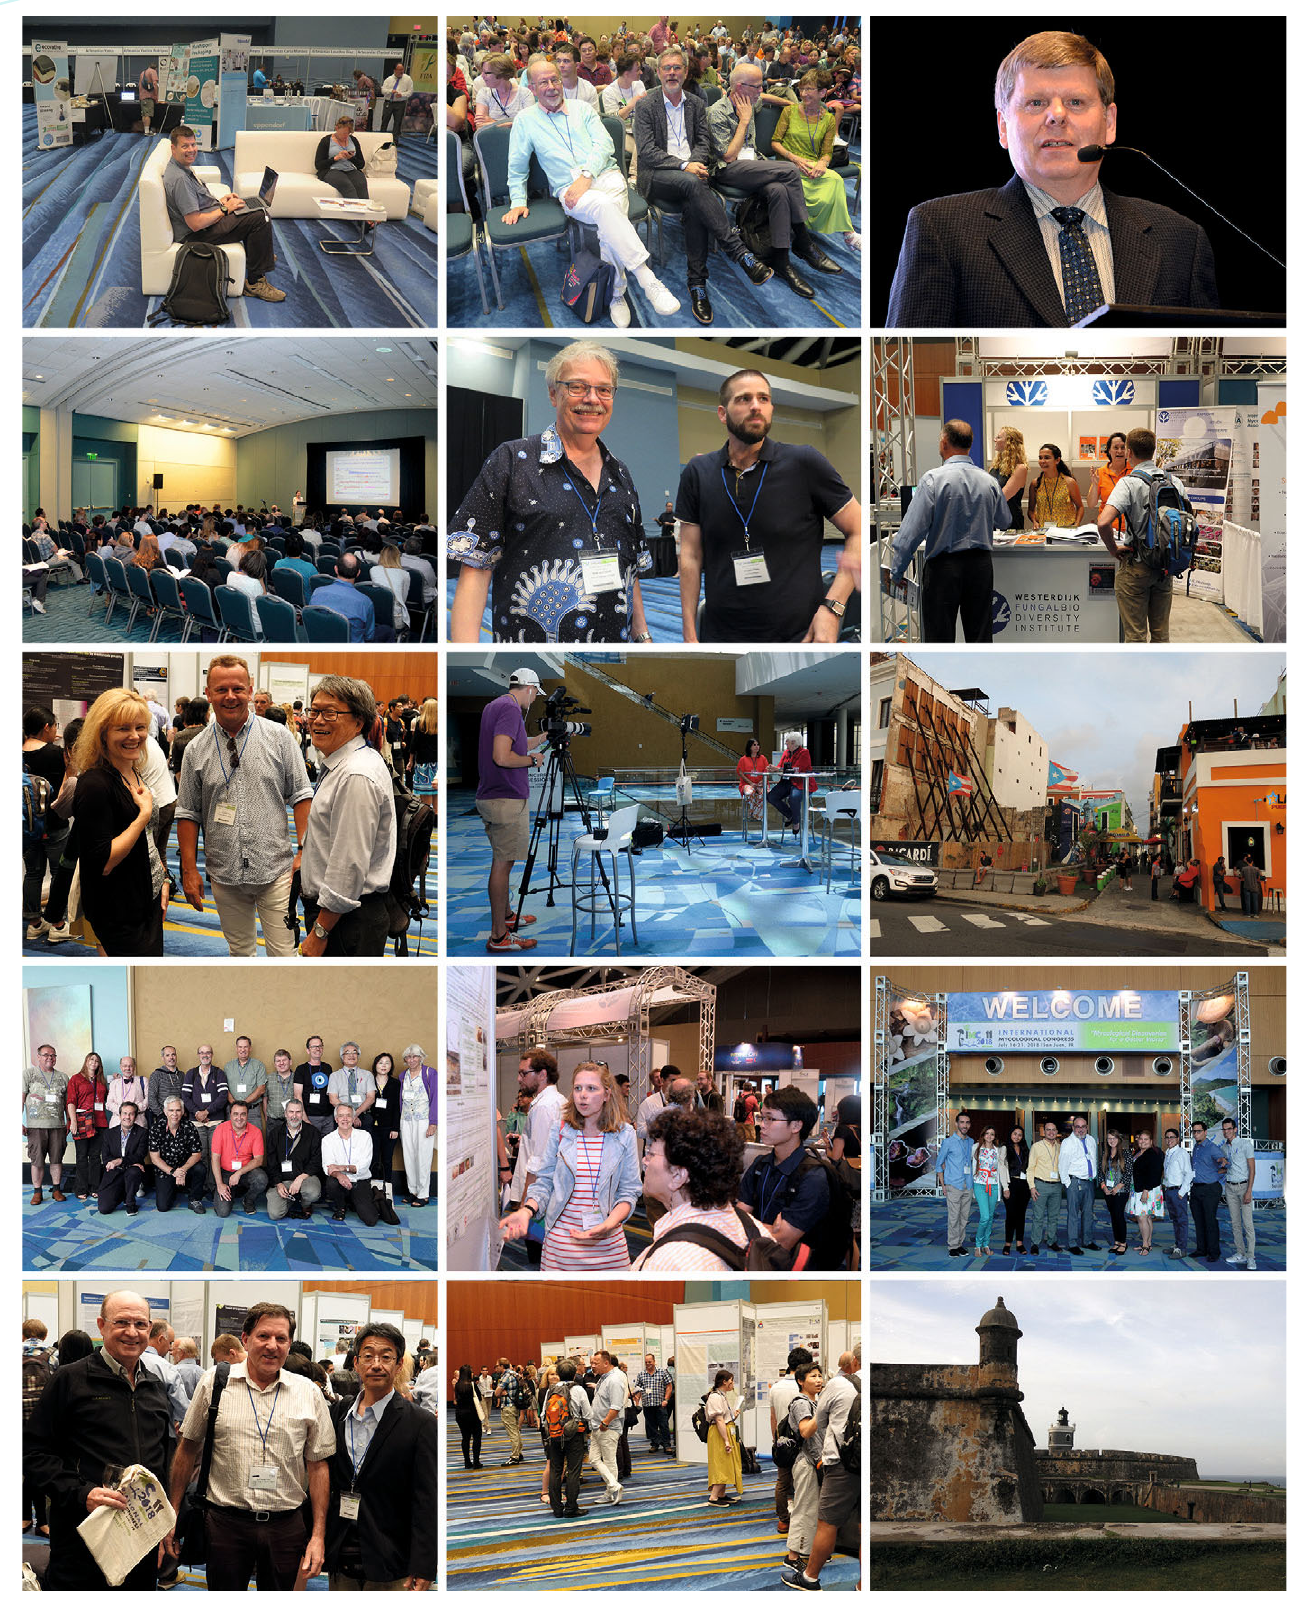
Scenes from the IMC11: 11 th International Mycological Congress, held in the Puerto Rico Convention Centre in San Juan, Puerto Rico, on 16—21 July